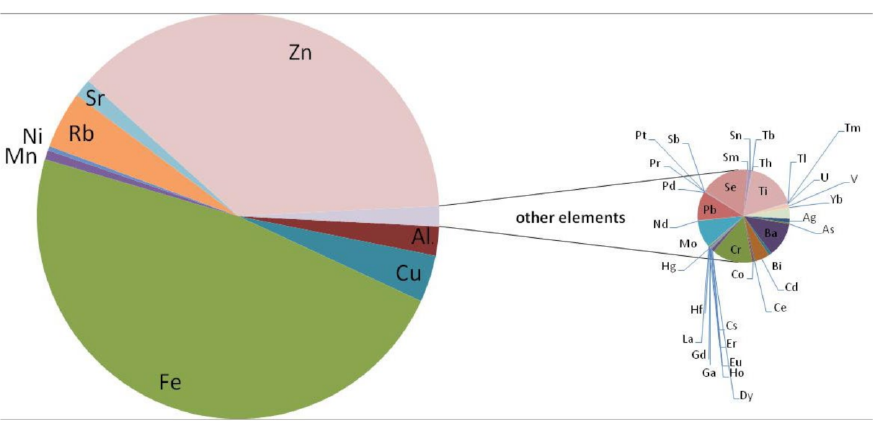
Figure 1. Pie of pie chart showing the percentage of trace elements (mean values) in the optic chiasm ( n = 187). The series was split by a value of 0.110